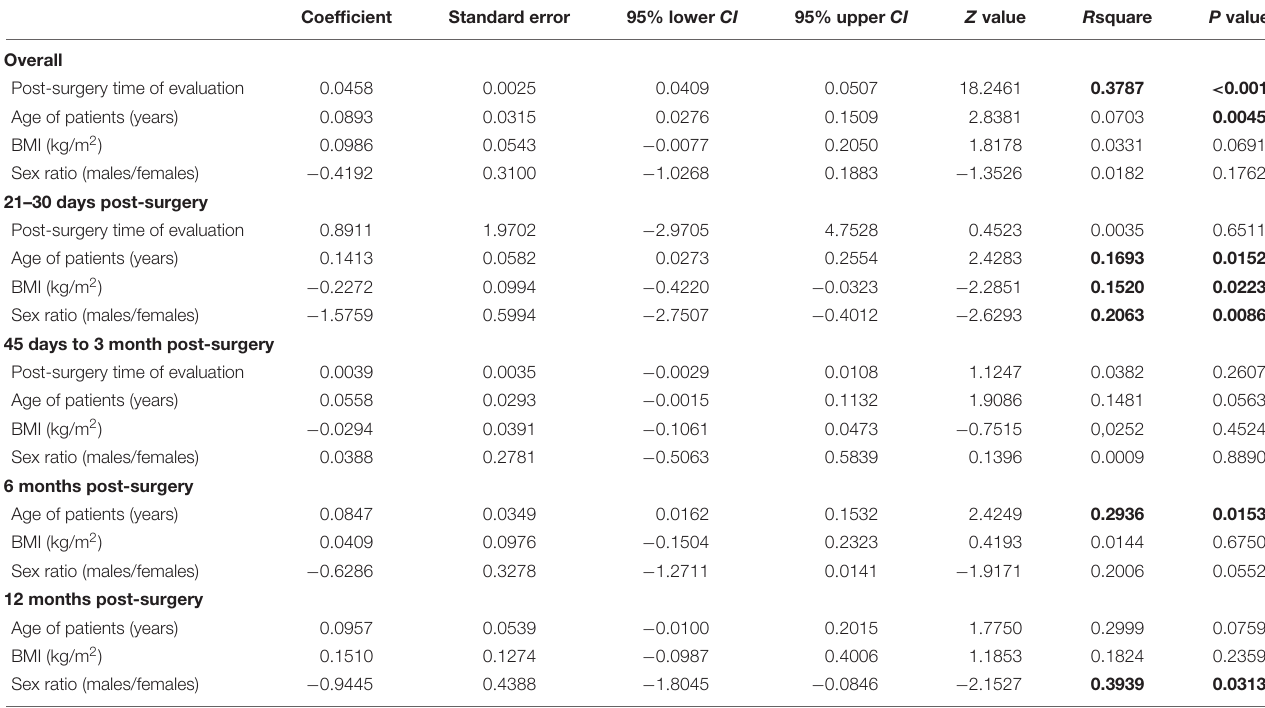
TABLE 4 | Meta-regression for variables to predict muscle strength at different time points following total knee